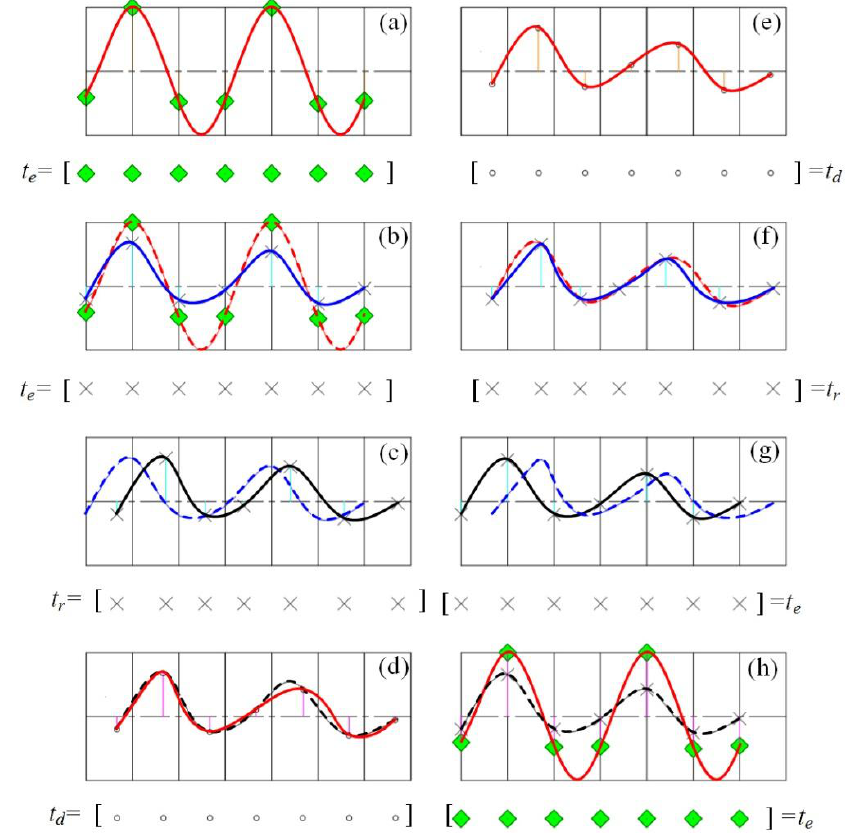
Figure 5. Illustration of the procedure of the construction of a PMDW and procedure of the